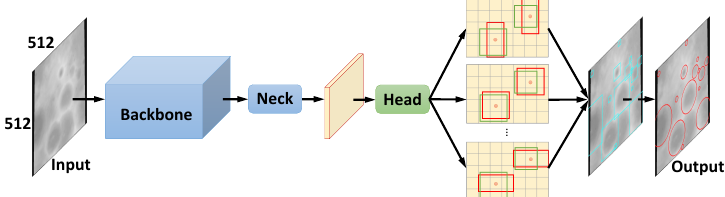
Figure 4. Architecture of the anchor-based detection network for lunar crater detection.